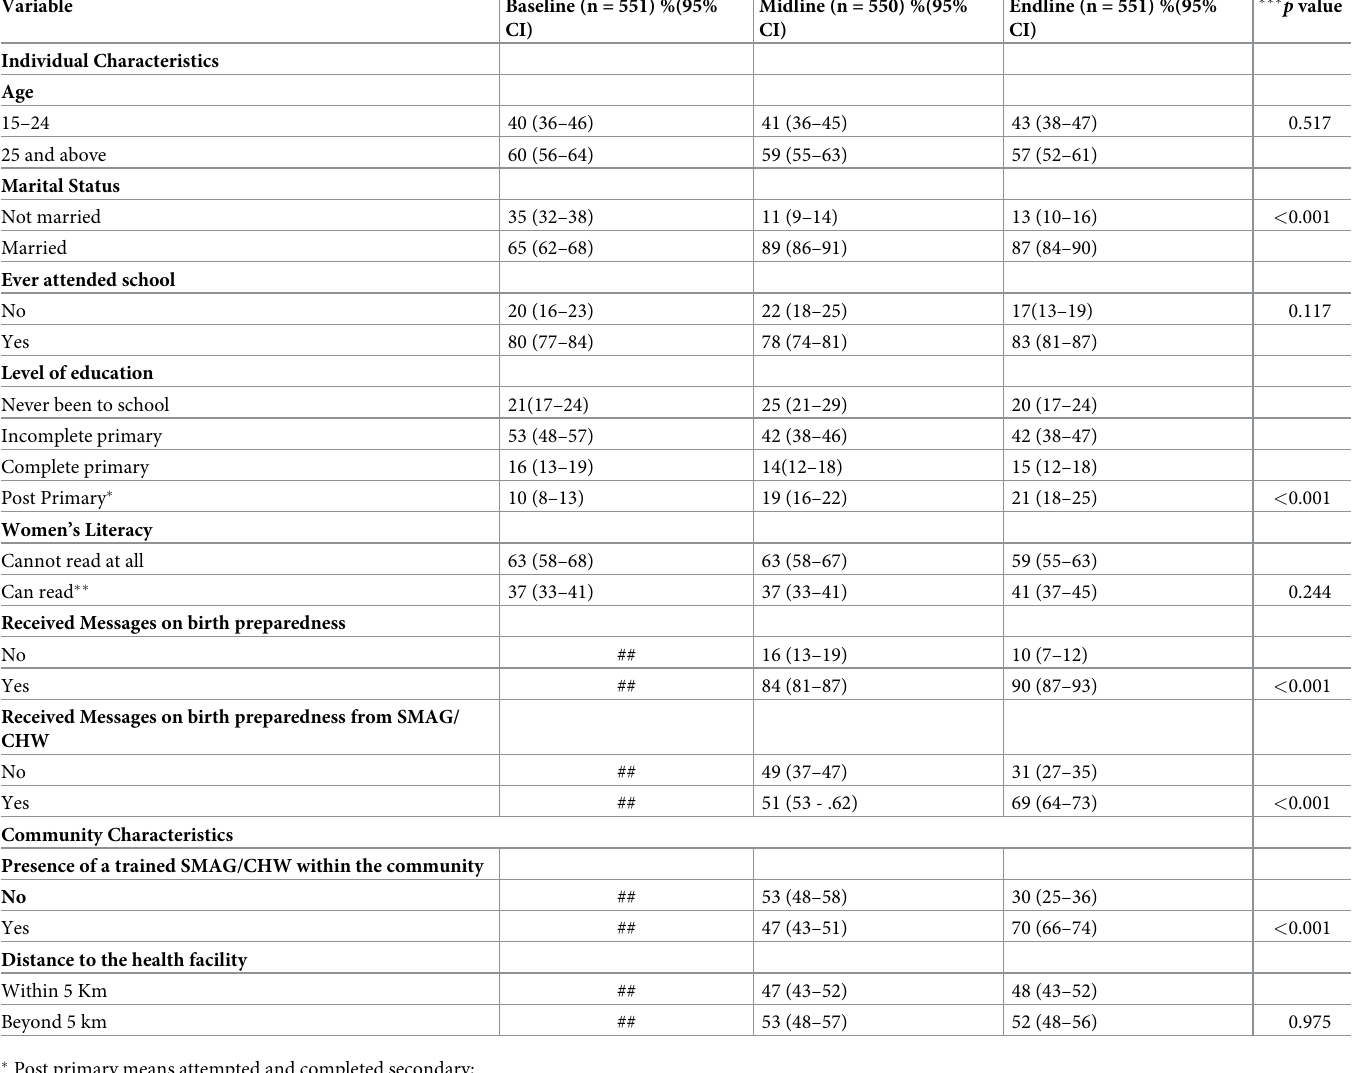
Table 1. Characteristics of mothers at Baseline, Midline and Endline surveys for the intervention. Variable Baseline (n = 551) %(95%